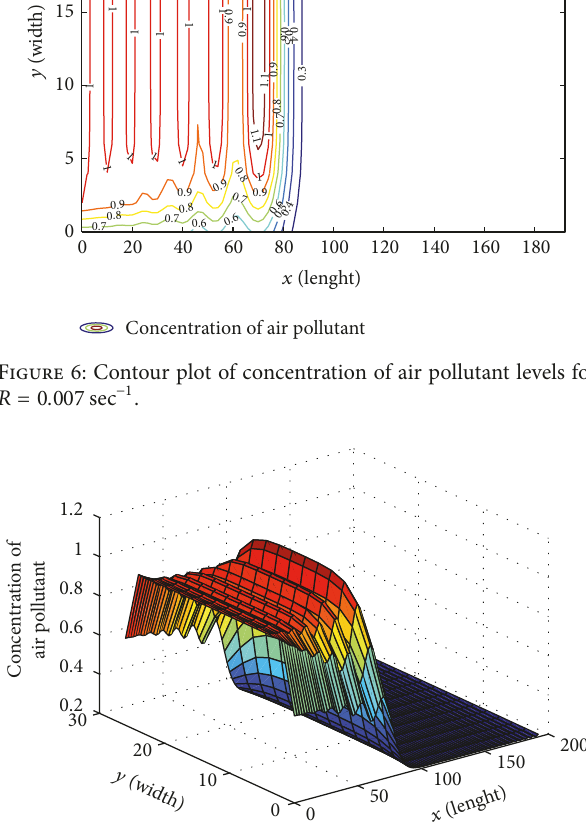
Figure 7: Surface plot of concentration of air pollutant levels for 𝑅 = 0.007 sec −1 .